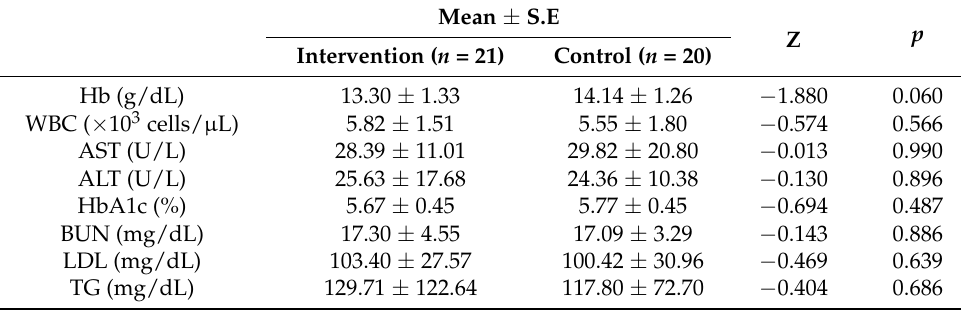
Table 4. Baseline blood test of participants.